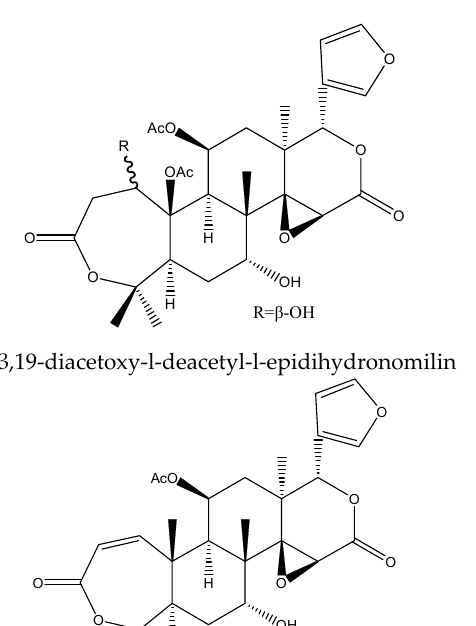
Figure 11. The structures of rings A,B-seco chemicals: aphanamixoids.